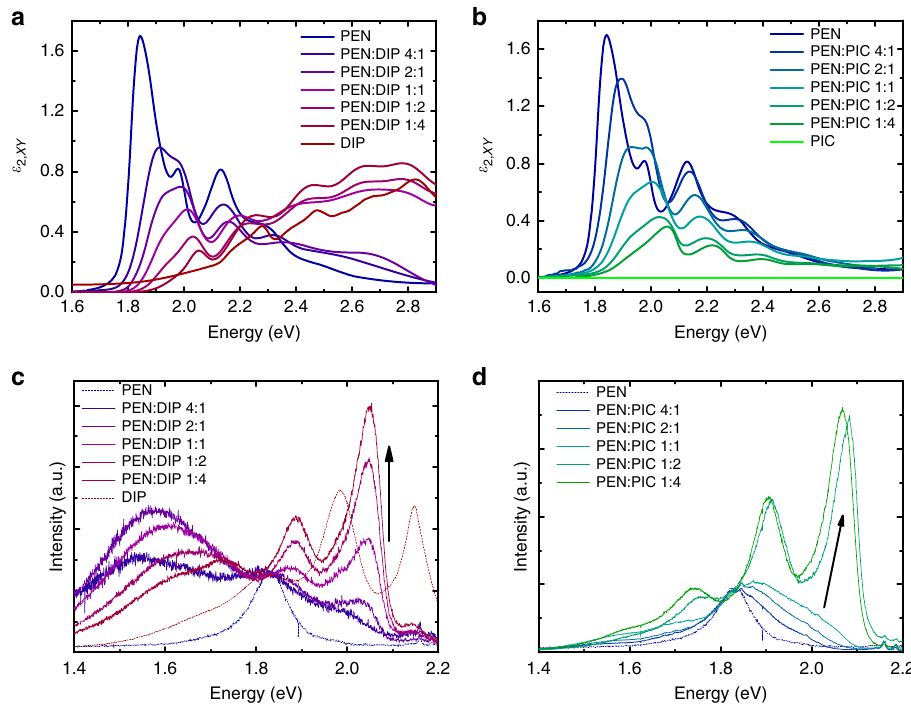
Fig. 2 Optical properties of the systems. a , b Absorption spectra. Data of PEN:DIP blends are adapted from ref. 28 . c , d PL-spectra. The intensities in c and d have been normalized to the intensity at 1.82 eV (PL-maximum of pure PEN). The arrows indicate changes with decreasing f PEN . For comparison, the pure fi lm spectra are included with the exception of PIC, which does not show PL in the relevant energy range